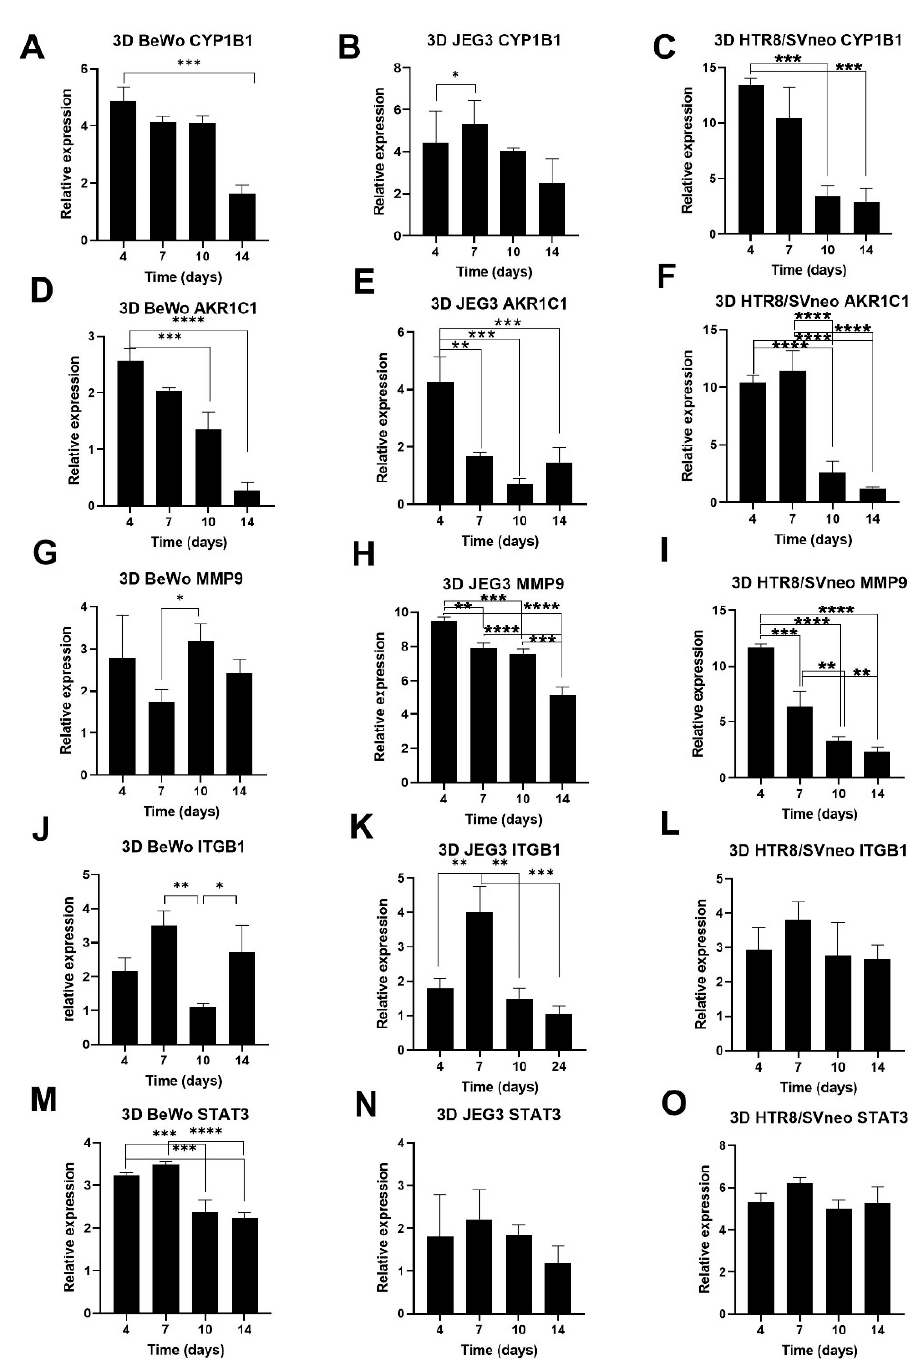
Figure 7. Gene expression kinetics in trophoblast spheroids. Time-course gene expression was performed in BeWo, JEG3 and HTR8/SVneo spheroids for CYP1B1 ( A – C ), AKR1C1 ( D – F ), MMP9 ( G – I ), ITGB1 ( J – L ) and STAT3 ( M – O ) at day 4, 7, 10 and 14 post-seeding. * p < 0.05; ** p < 0.01; *** p < 0.001; **** p <